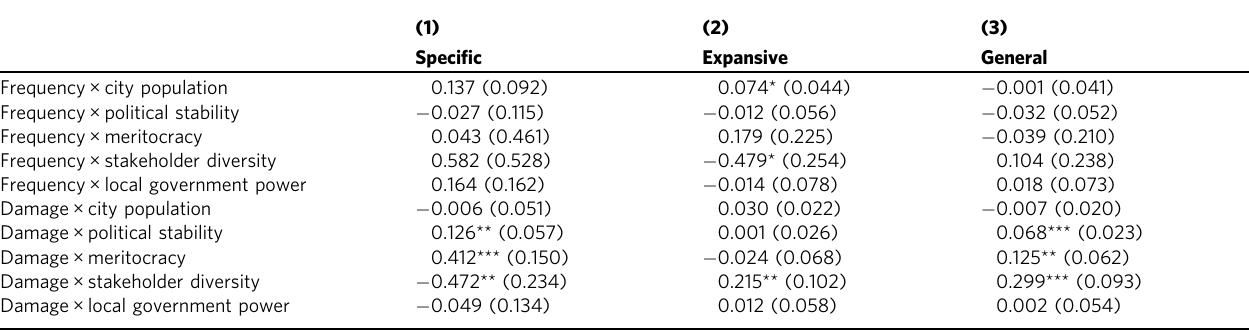
Table 2 Results of moderation analyses, including interaction effects of event frequency, economic damage, city population, and adaptive capacity attributes on speci fi c, expansive, and general adaptation